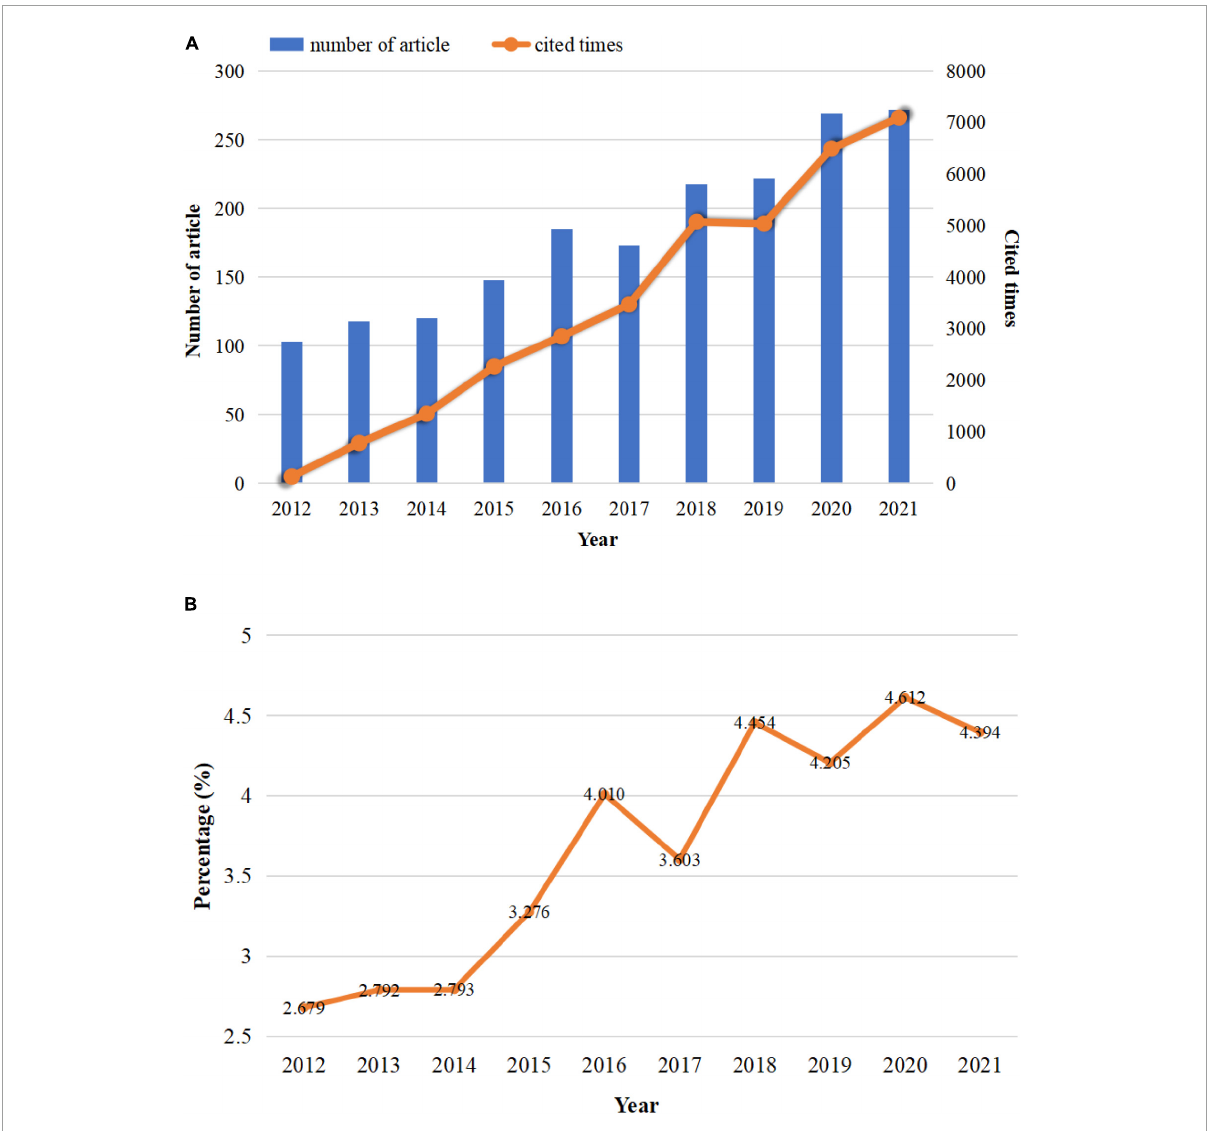
FIGURE1 Trends in the growth of publications from 2012 to 2021. (A) The number of publications and citations per year on vitamin D and reproductive health. (B) Trends in the proportion of research on vitamin D and reproductive health in vitamin D-related research.